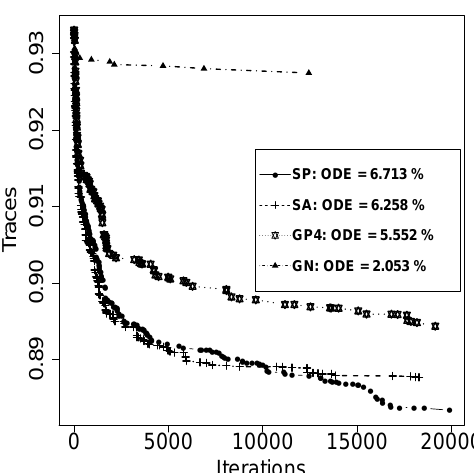
Figure 4. Traces from successful swaps to convey the rate of convergence for simple pairwise (SP), simulated annealing (SA), greedy pairwise (GP4), and genetic neighborhood (GN) algorithms with their overall design efficiencies (ODE) evaluated for half-sib families with h 2 = 0.1, ρ = 0.6 and a nugget error of 0.1 iterated for 20,000 for a practical Ω